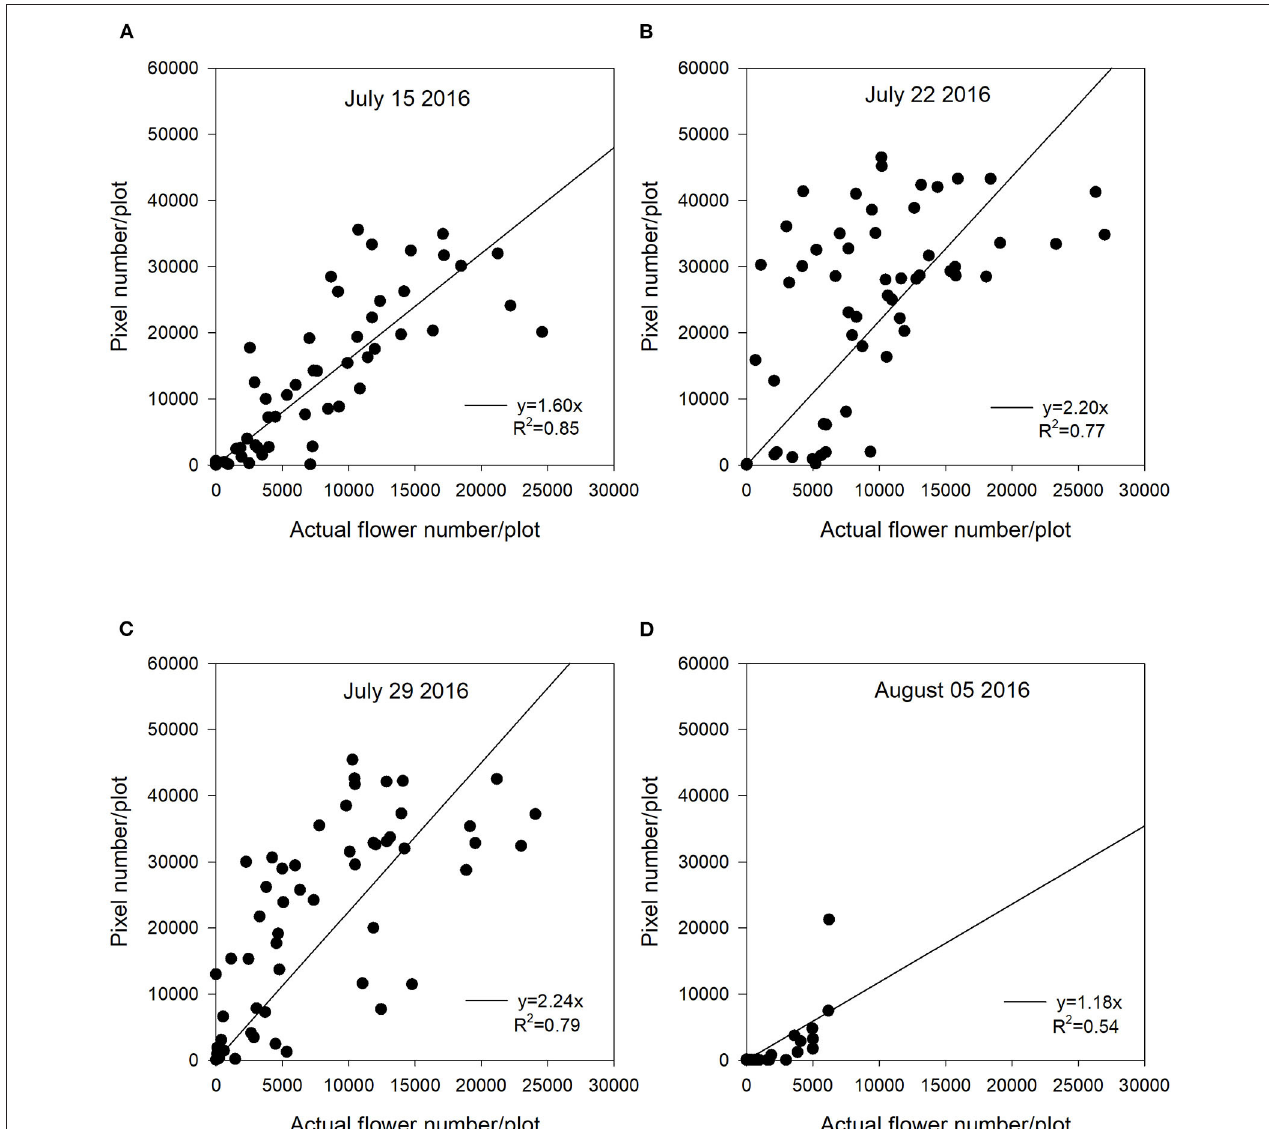
FIGURE 3 | The relationship between actual flower numbers per plot and pixel numbers extracted from aerial images during the flowering stage at Saskatoon, SK, Canada in 2016. Actual flower numbers per plot were manually measured. Pixel number per plot was detected by the thresholding method. (A) Regression equation for July 15, 2016: y = 1.60x, R 2 = 0.85. (B) Regression equation for July 22, 2016: y = 2.20x, R 2 = 0.77. (C) Regression equation for July 29, 2016: y = 2.24x, R 2 = 0.79. (D) Regression equation for August 05, 2016: y = 1.18x, R 2 =